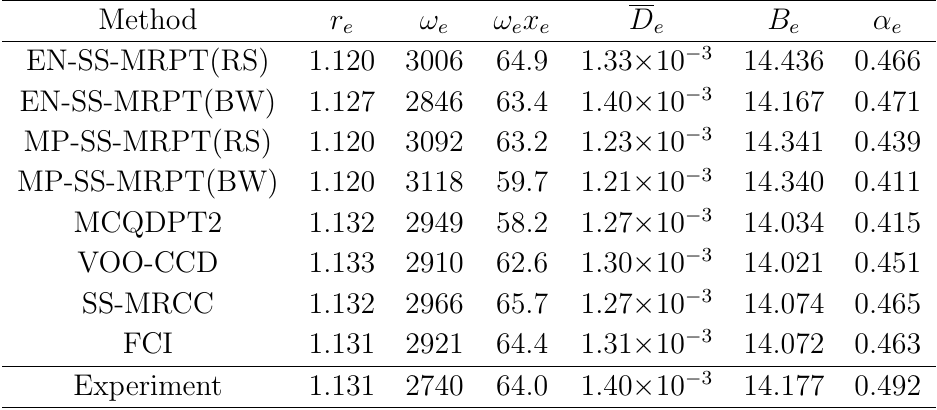
Table 1: Spectroscopic constants for the ground electronic state of CH +